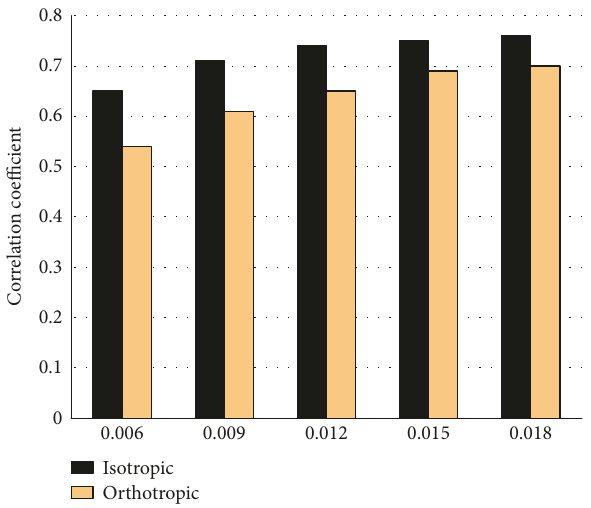
Figure 2: The correlation coe ffi cients between the real bone densities and those simulated by the isotropic and orthotropic algorithms. Five values of reference stimulus Ψ used for simulation,